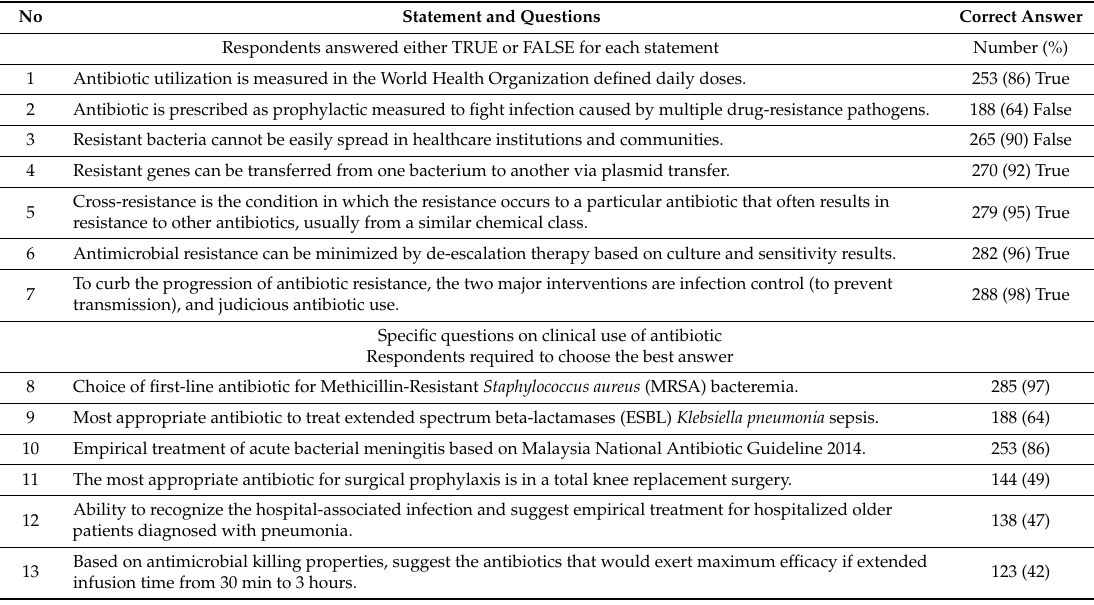
Table 2. Respondents’ knowledge on antibiotic use and resistance ( n = 294